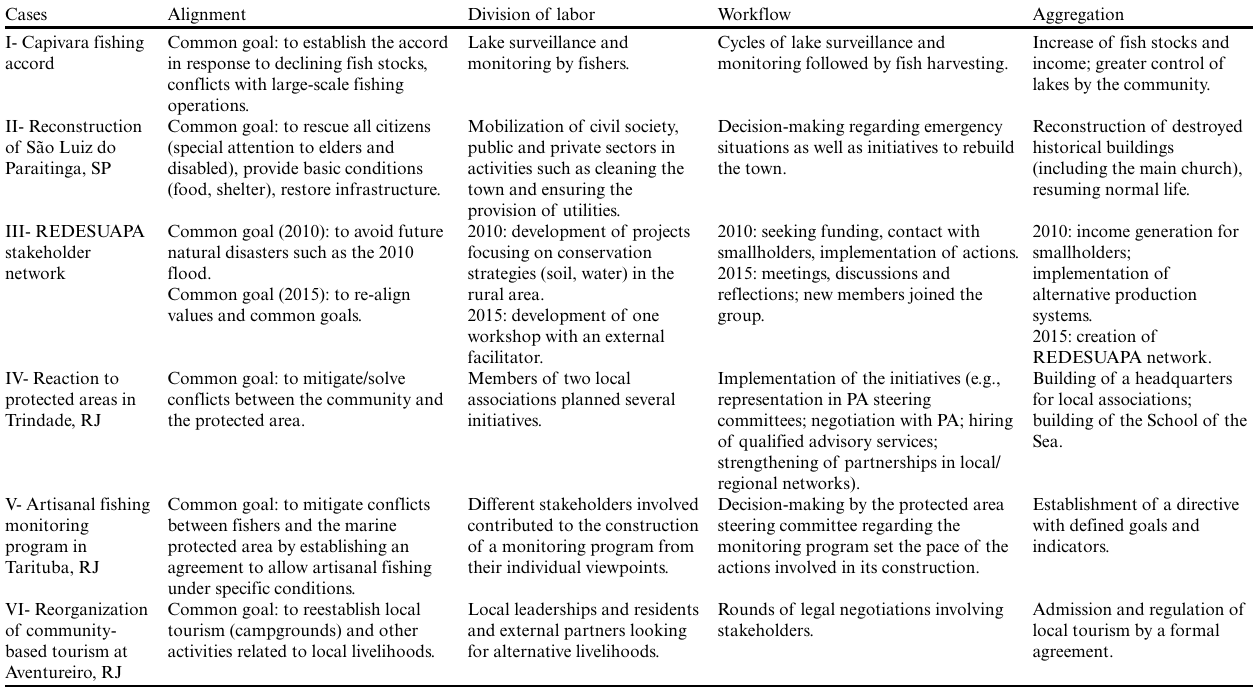
Table 1. Key words and expressions from each case of successful community self-organization in Brazil related to the basic mechanisms of coordinated self-organization proposed by Heylighen